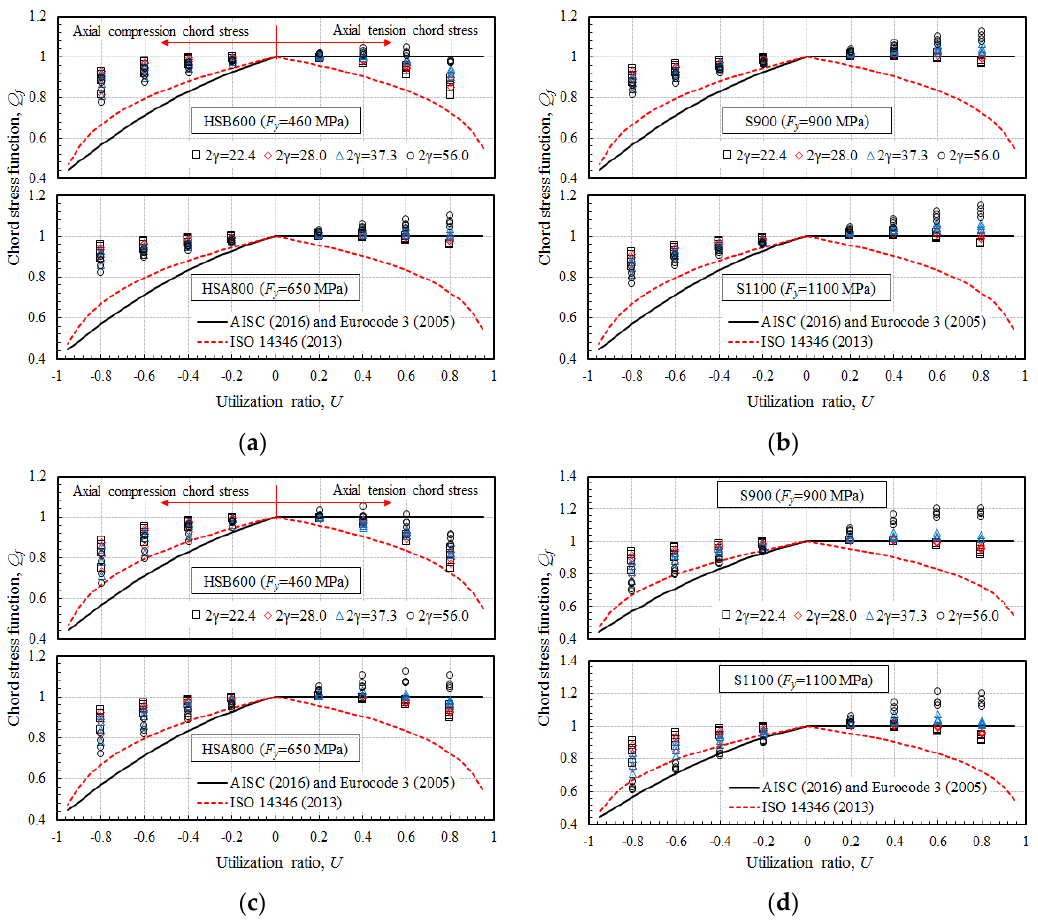
Figure 14. Comparison of the chord stress functions with parametric analysis results: ( a ) HSB600 and HSA800 steel with R 3% D ; ( b ) S900 and S1100 steel with R 3% D ; ( c ) HSB600 and HSA800 steel with R max ; ( d ) S900 and S1100 steel with R max .